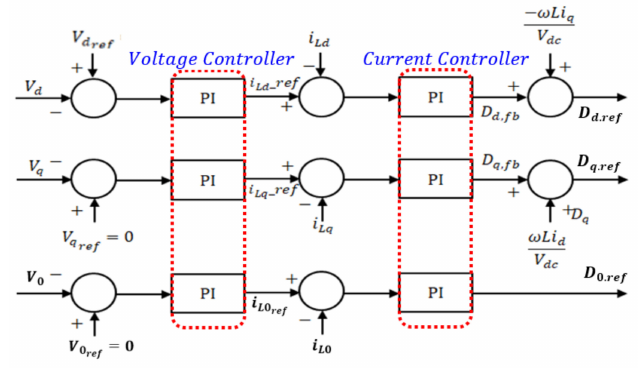
Figure 10. Two-loop PWM inverter dq 0 controller block